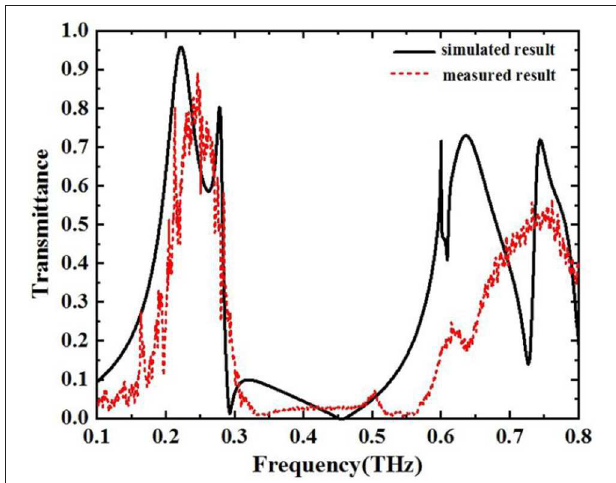
FIGURE 6 | Measured transmittance spectra of the proposed two-layer crossing fractal